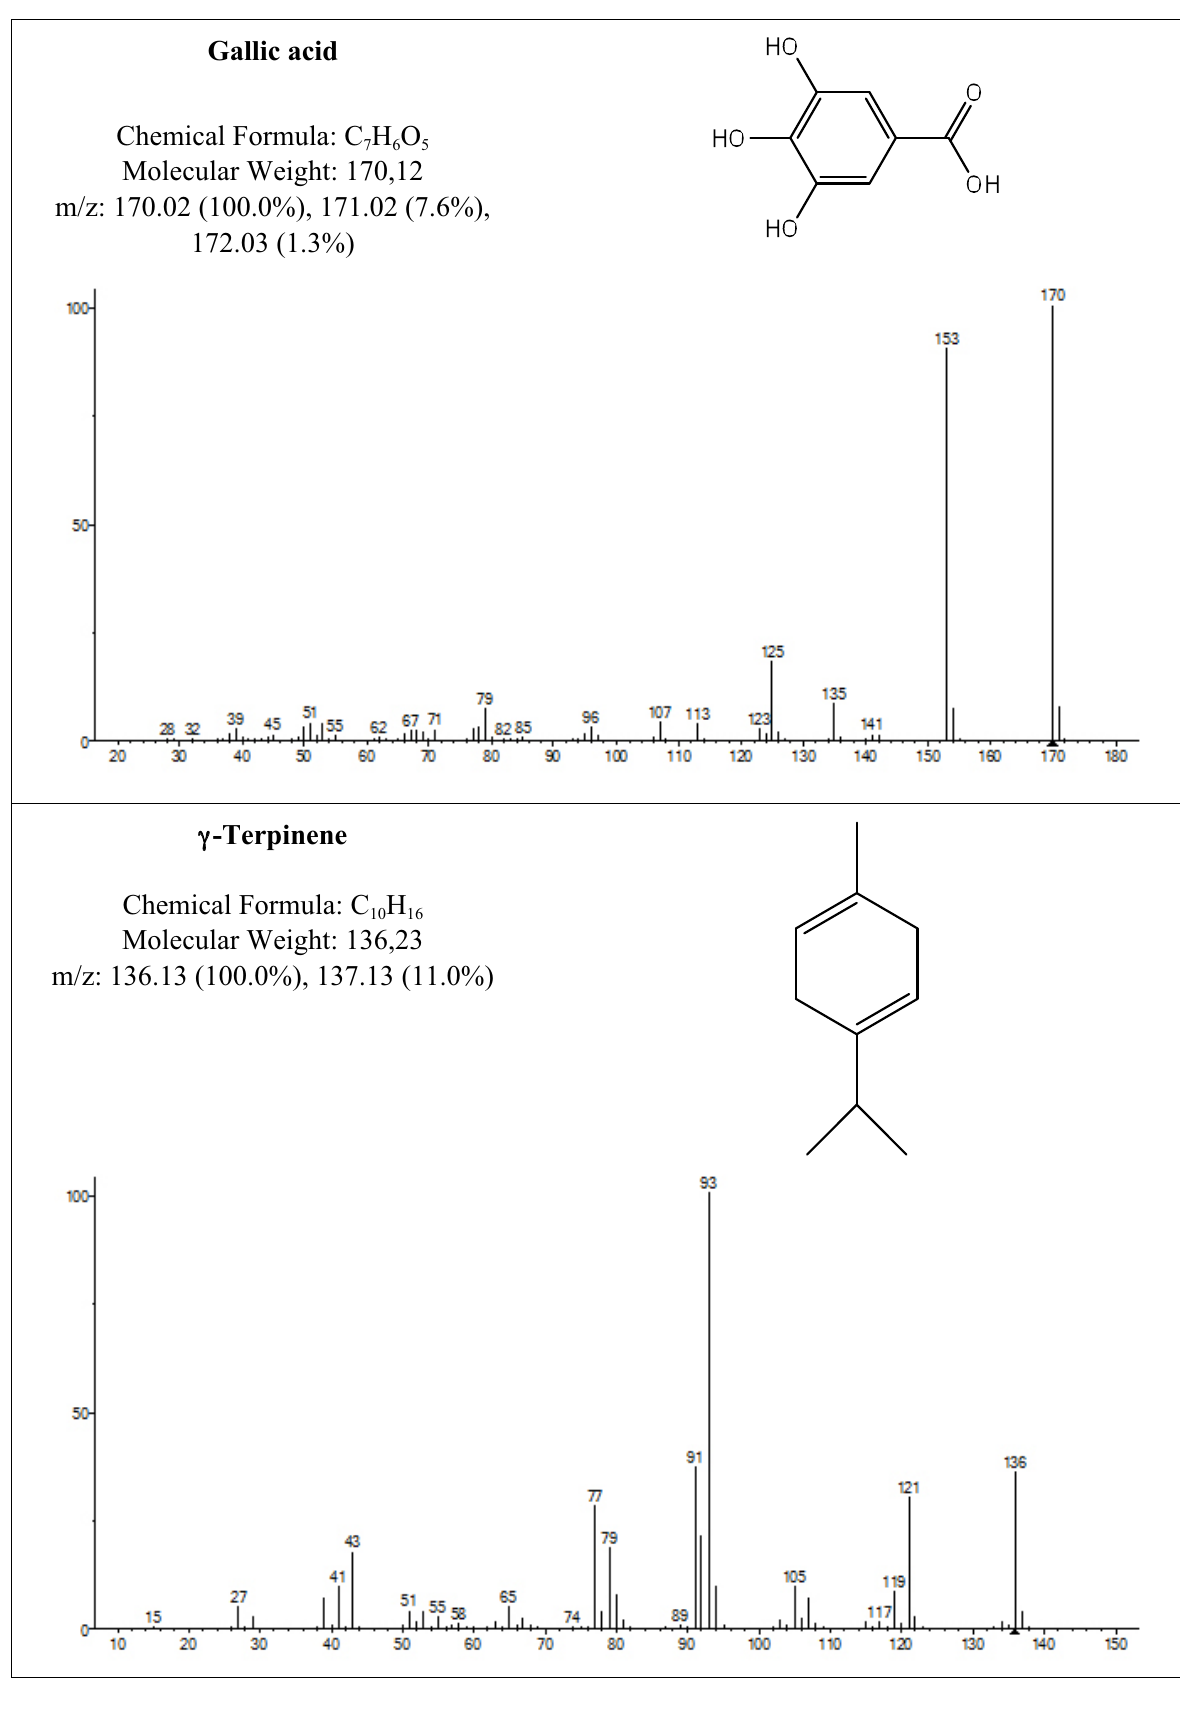
Fig. S1: Mass spectrometry data of some selected phytochemicals in B. ramiflora decoctions and